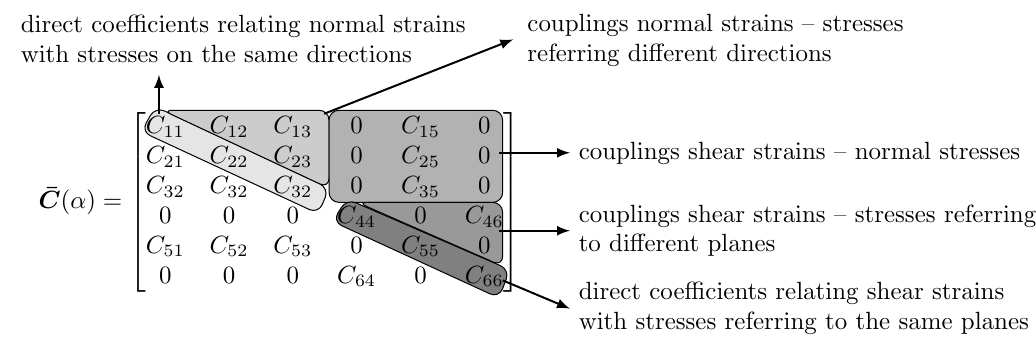
Figure 11. Subdivision of the elastic matrix. Table 3. Transversely isotropic soil: material parameters for the 3D